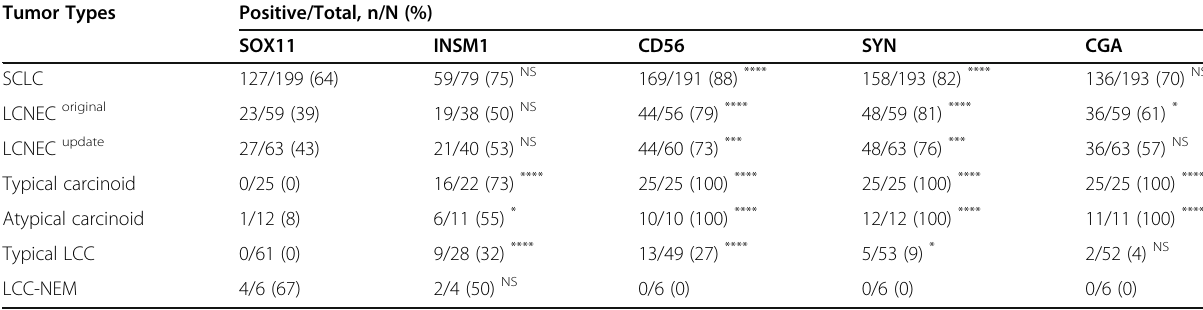
Table 1 Expression of neuroendocrine markers in pulmonary neuroendocrine tumors and large cell carcinoma Tumor